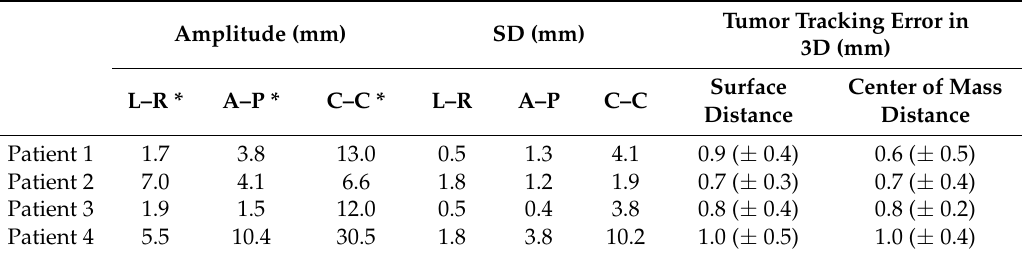
Table 2. Tumor motion during the entire respiratory cycle along the L–R, A–P, and C–C directions for patients 1 through 4. The tumor motion is reported in terms of the maximum amplitude (max-min) and standard deviation (SD) of the centroid of mass of the tumors. The patients (patients 5 and 6) with little tumor motion (amplitude of < 1 mm) are not